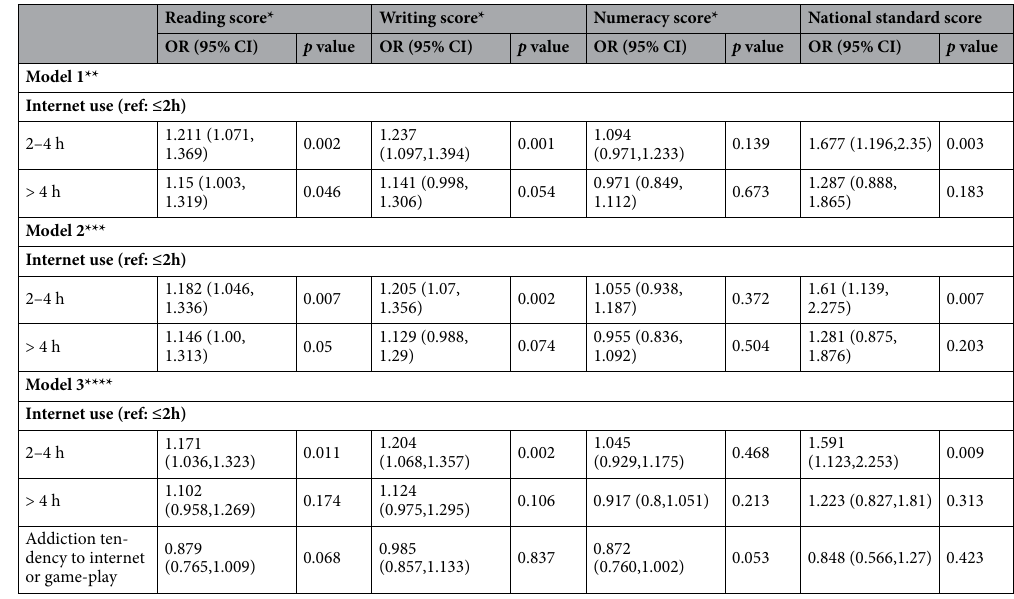
Table 4. Generalized linear model fitted to various scores and national standard scores for weekends internet use adjusting the behavioural and sociodemographic factors, as well as survey weights. *Standardized (mean of 0 and a standard deviation of 1). **The model was adjusted for age and sex of the child, household income, primary carer’s education and family type. ***Model 2 was adjusted for age and sex of the child,